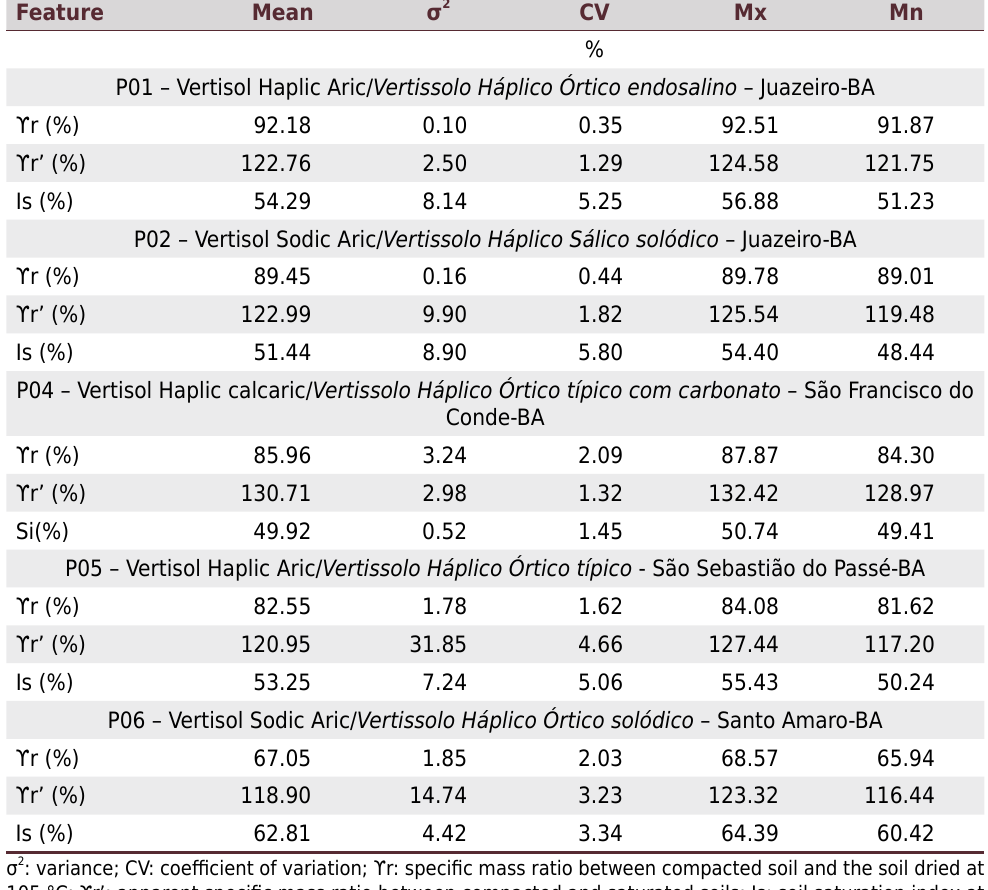
Table 7. Compaction test applied to some kaolinite-rich Brazilian Vertisols